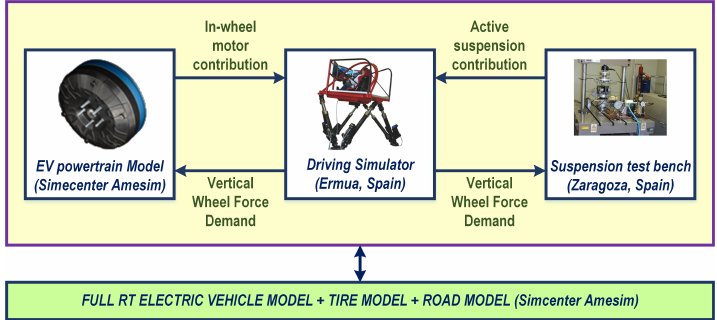
Figure 10. XILforEV configuration for ride blending studies.